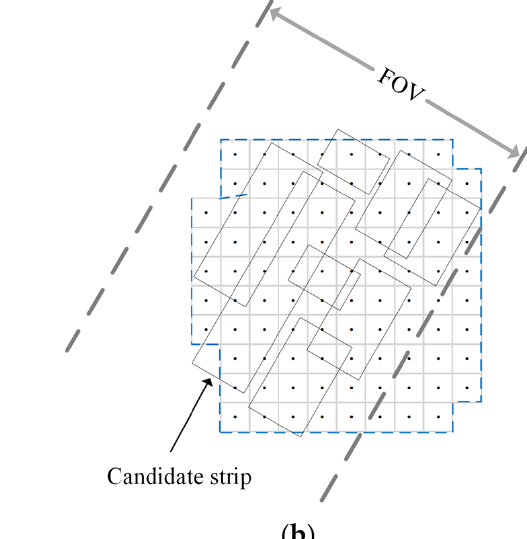
Figure 6. Two modes to generate candidate strip. ( a ) Parallel split; ( b ) grid split proposed in this paper.